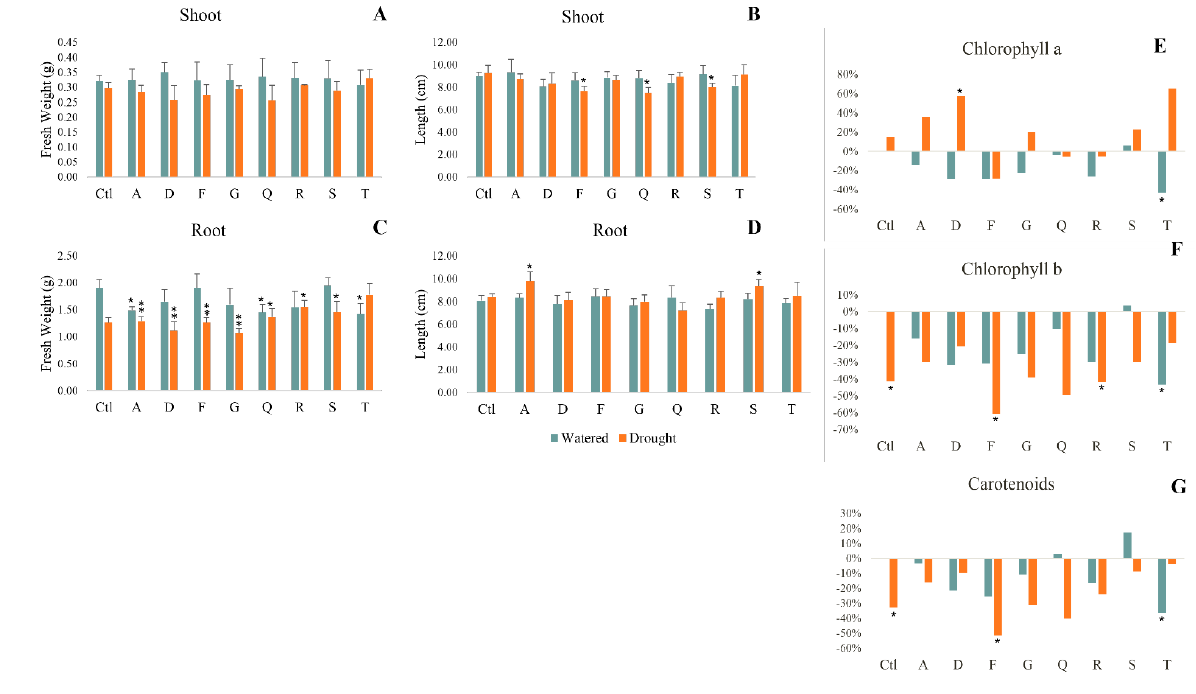
Figure 2. Maize plants grown for 7 days in watered and drought conditions. Morphometric param- eters: fresh weight ( A ) and length ( B ) of shoots; fresh weight ( C ) and length ( D ) of roots. Variation of photosynthetic pigments relatively to control (watered and non-inoculated plants): chlorophyll a ( E ), chlorophyll b ( F ) ad carotenoids ( G ). Watered (greenish bars) and drought (orange bars) plants were inoculated with different strains: Pantoea spp. (A); Pseudomonas spp . (D); Acinetobacter spp . (F); Stenotrophomonas spp . (G); Pseudomonas spp . (Q); Rhizobium spp .(R); Stenotrophomonas spp . (S); Pseudomonas spp . (T). Values are means of three replicates + standard deviation. Significant differ- ences compared to non-inoculated watered plants (control) were marked with single asterisks ( p < 0.05) or double asterisks ( p < 0.01). For additional information (means, standard deviation and sta- tistical significance) see supplementary Table S2.